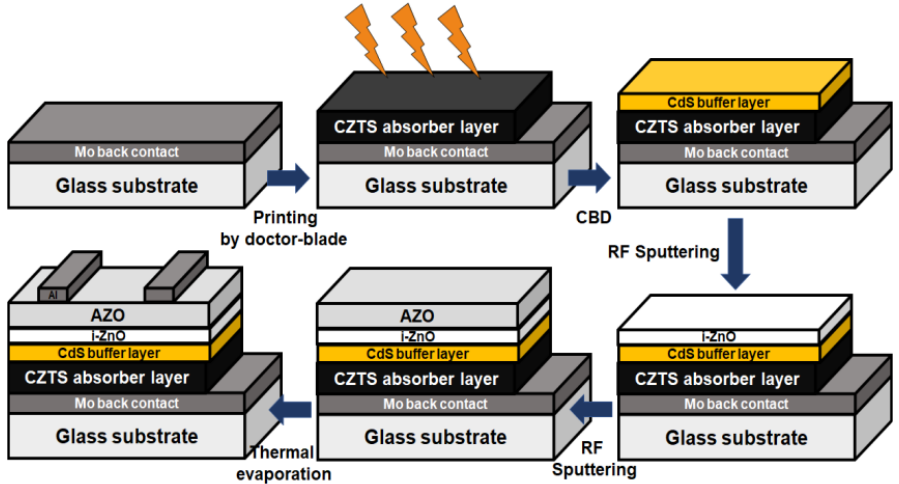
Figure 6. Schematic of the CZTS solar cell fabrication process.